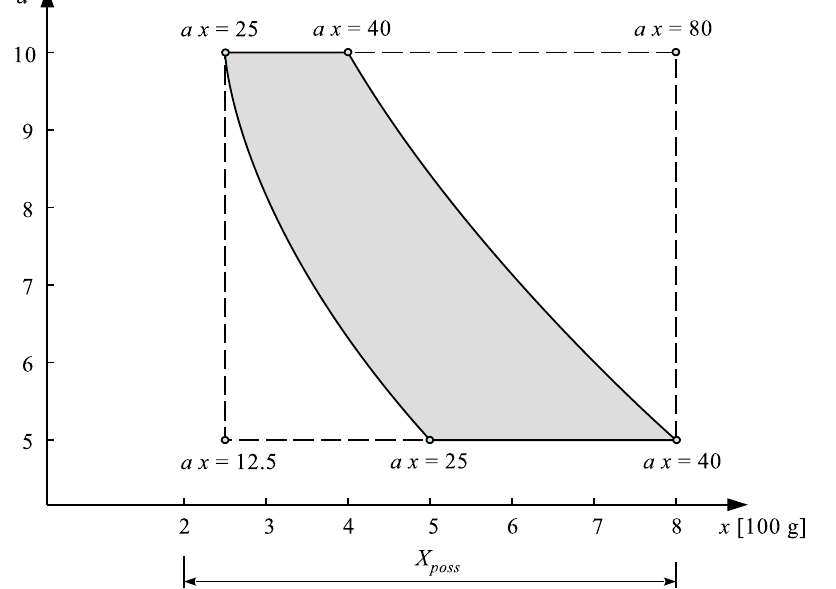
Figure 17. Set of possible states of the system [ 5,10 ] x = [ 25,40 ] in projection on the 2D-space A × X .